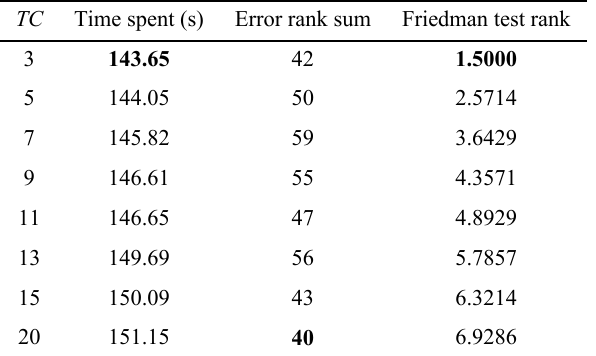
Table 12 Ranking of different TC values when D = 50.